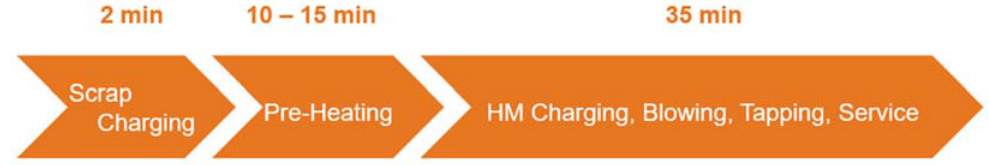
Figure 8. Typical processing time for BOF with scrap preheating.